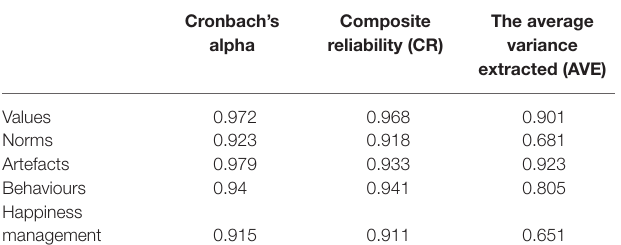
TABLE 4 | Consistency and reliability analysis.